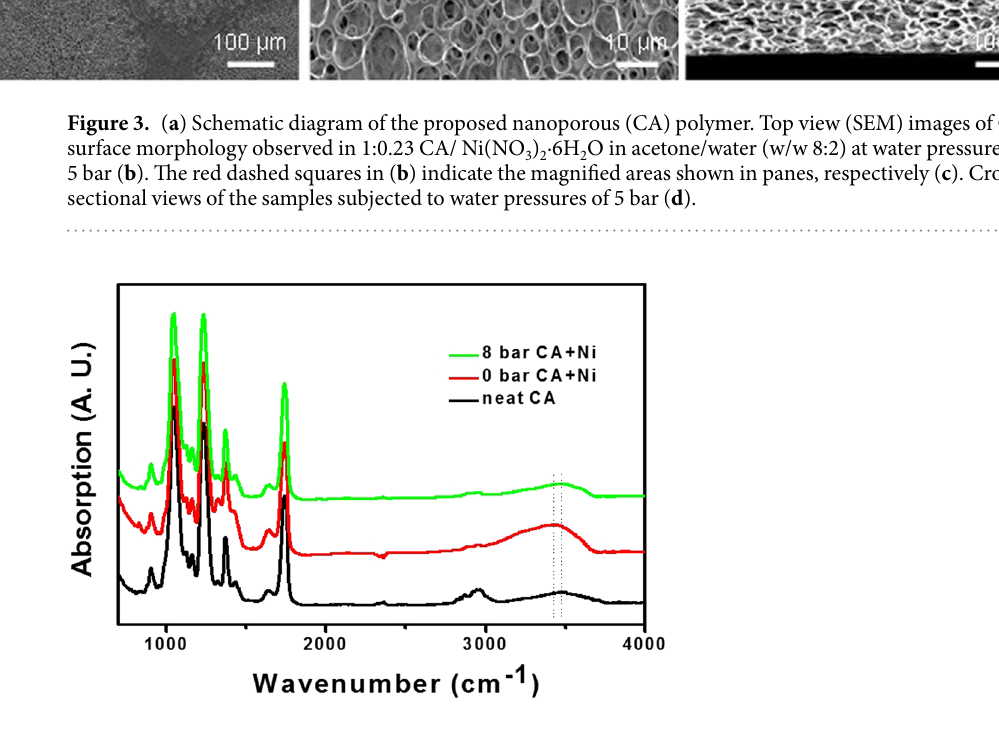
Figure 4. Fourier transform infrared (FT-IR) spectra of neat cellulose acetate (CA) and the 1:0.23 CA/ Ni(NO 3 ) 2 ·6H 2 O polymer matrix at water pressures of 0 bar and 8